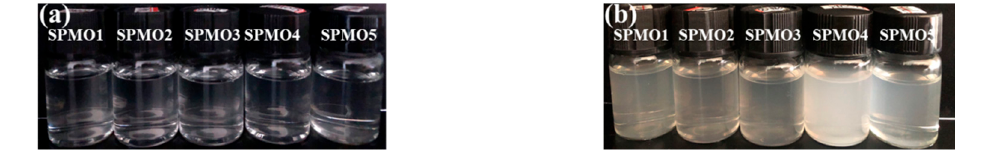
/ mL) at ( a ) 25 ◦ C and ( b ) 35 ◦